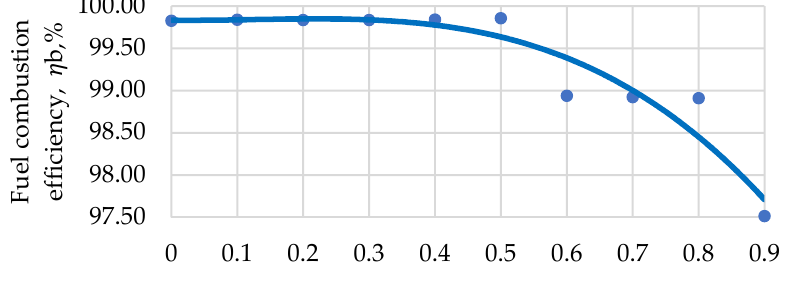
Figure 6. Dependence of fuel combustion efficiency on degree of dilution with water vapor as per Chemkin-Pro. Table 5. Dependence of combustion efficiency on degree of dilution with the water vapor.